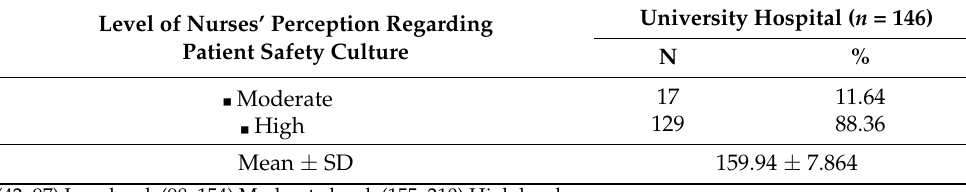
Table 1. Socio-Demographic and Work-Related Characteristics of the Study Subjects. Table 2. Nurses’ Level of Perception Regarding Patient Safety Culture. Nurses Socio-Demographic Characteristics